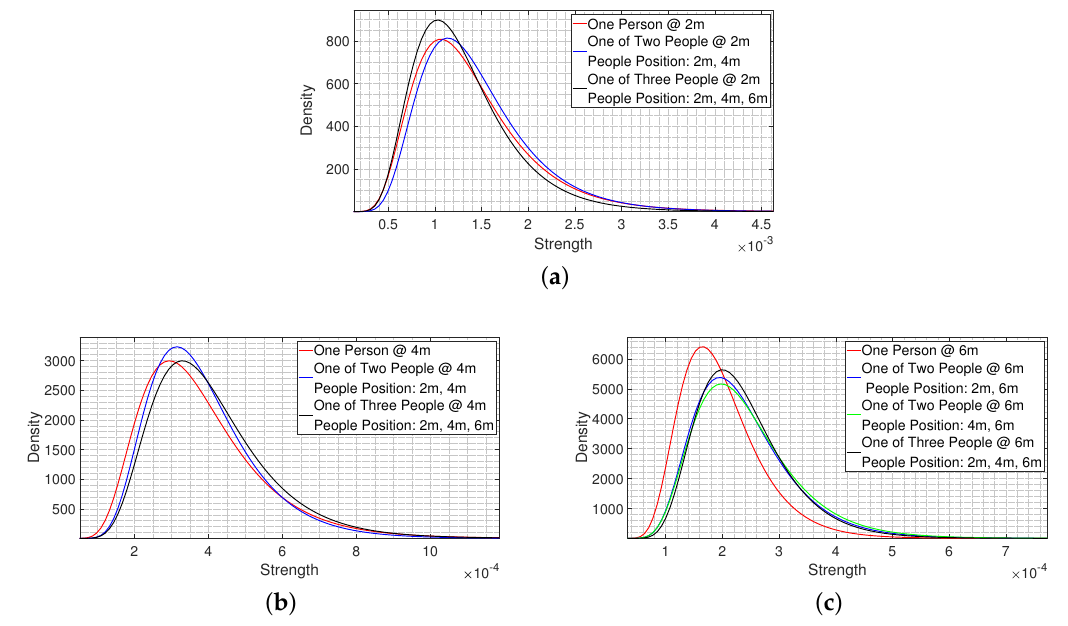
Figure 16. The fitting results in multiple people environments. ( a ) The fitting result at 2 m. ( b ) The fitting result at 4 m. ( c ) The fitting result at 6